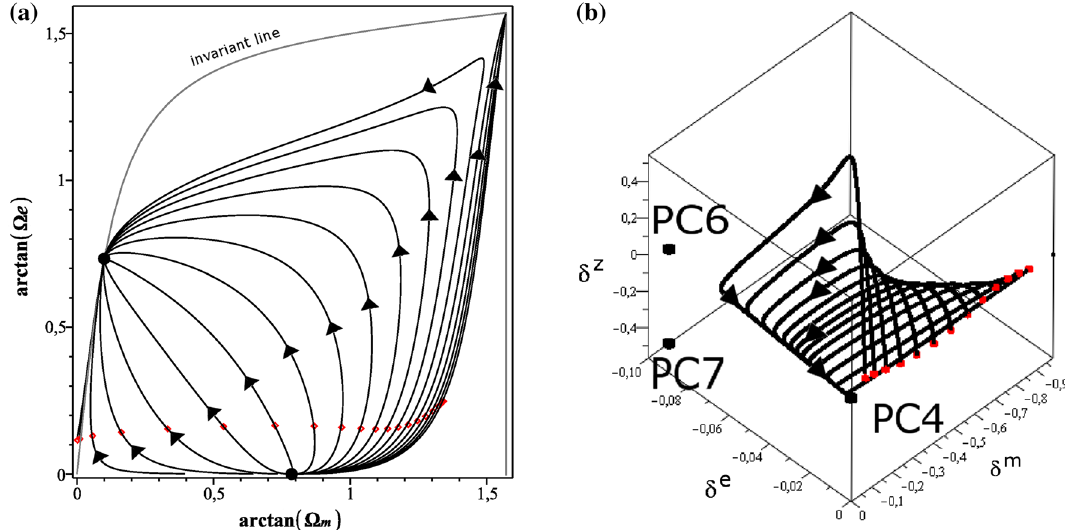
Fig. 3 a Homogeneous projection of the trajectories of the system (20a–20e) for the different shells of the configuration with initial con- ditions given by (31) and w = − 1 . 0, α = 0 . 1. The grey line represents the invariant line for this choice of parameters. The points represents